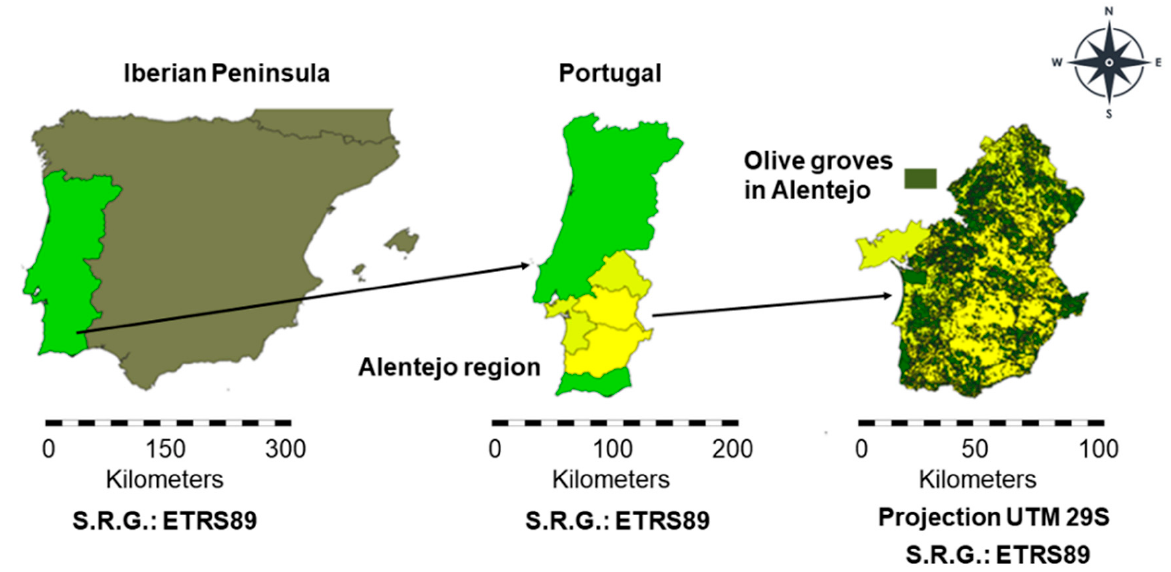
Figure 1. Geographical location of the study area and distribution of olive groves. In this region, a Mediterranean climate predominates, with an average annual rainfall of 450–750 mm, dry summers with average temperatures between 24–28 ◦ C, and wet winters with temperatures ranging between 8–11 ◦ C [7,37]. Although Alentejo accounts for approximately 51% of the national olive-growing area in Portugal, exceeding 179,000 ha [6], these crops have not until very recently become monocultures of significance at regional level, with traditional olive groves having instead historically been components of hetero- geneous, complex, and multifunctional landscape mosaics formed by agricultural systems, alongside holm oak ( Quercus ilex , L. 1753)- and cork oak ( Quercus suber , L. 1753)-dominated silvopastoral systems, nationally known as Montados [38]. However, it is important to highlight the relevance, in socioproductive terms, of the olive groves at the regional